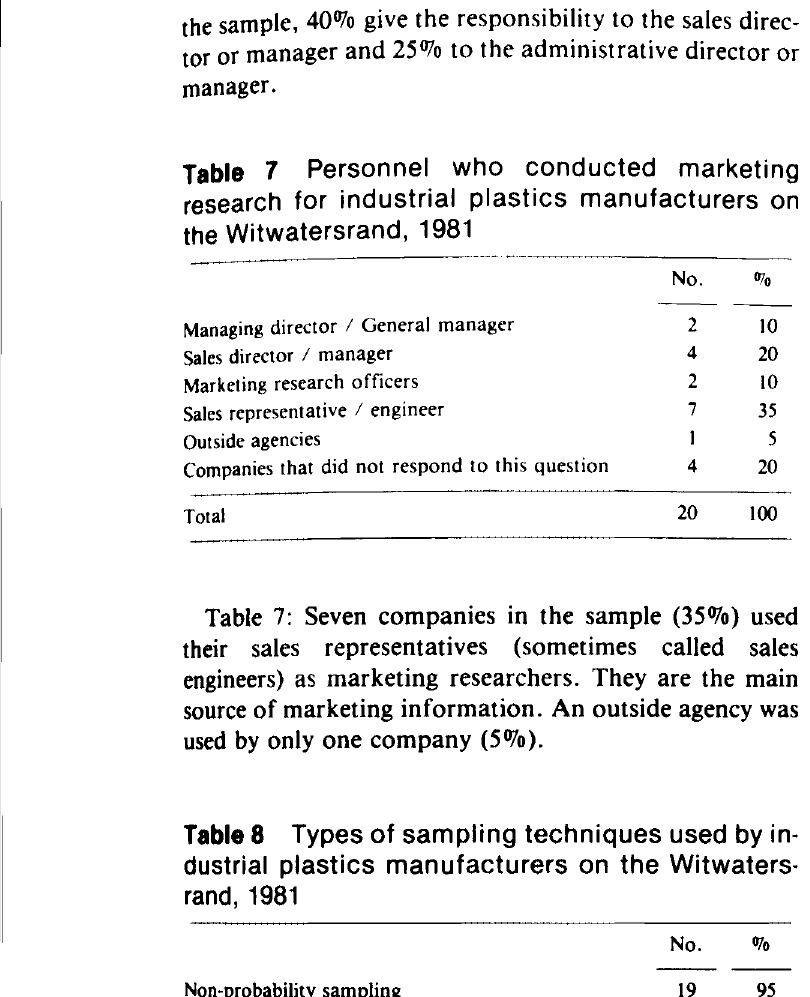
Table 8: It is clear that the majority of firms in the sample (950Jo) use non-probability sampling